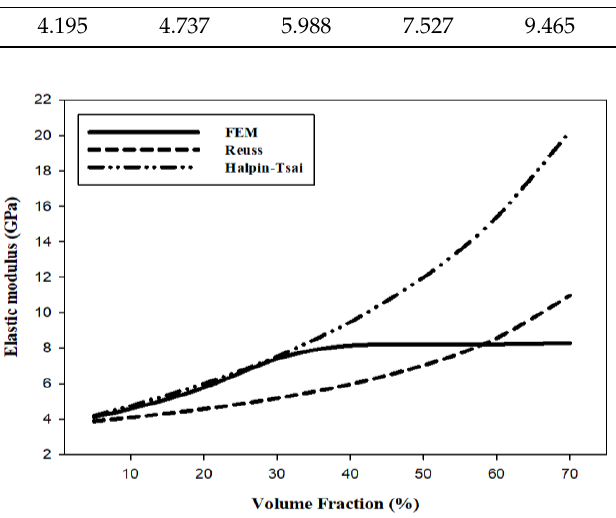
Figure 5. Elastic modulus predictions as a function of AP VF.